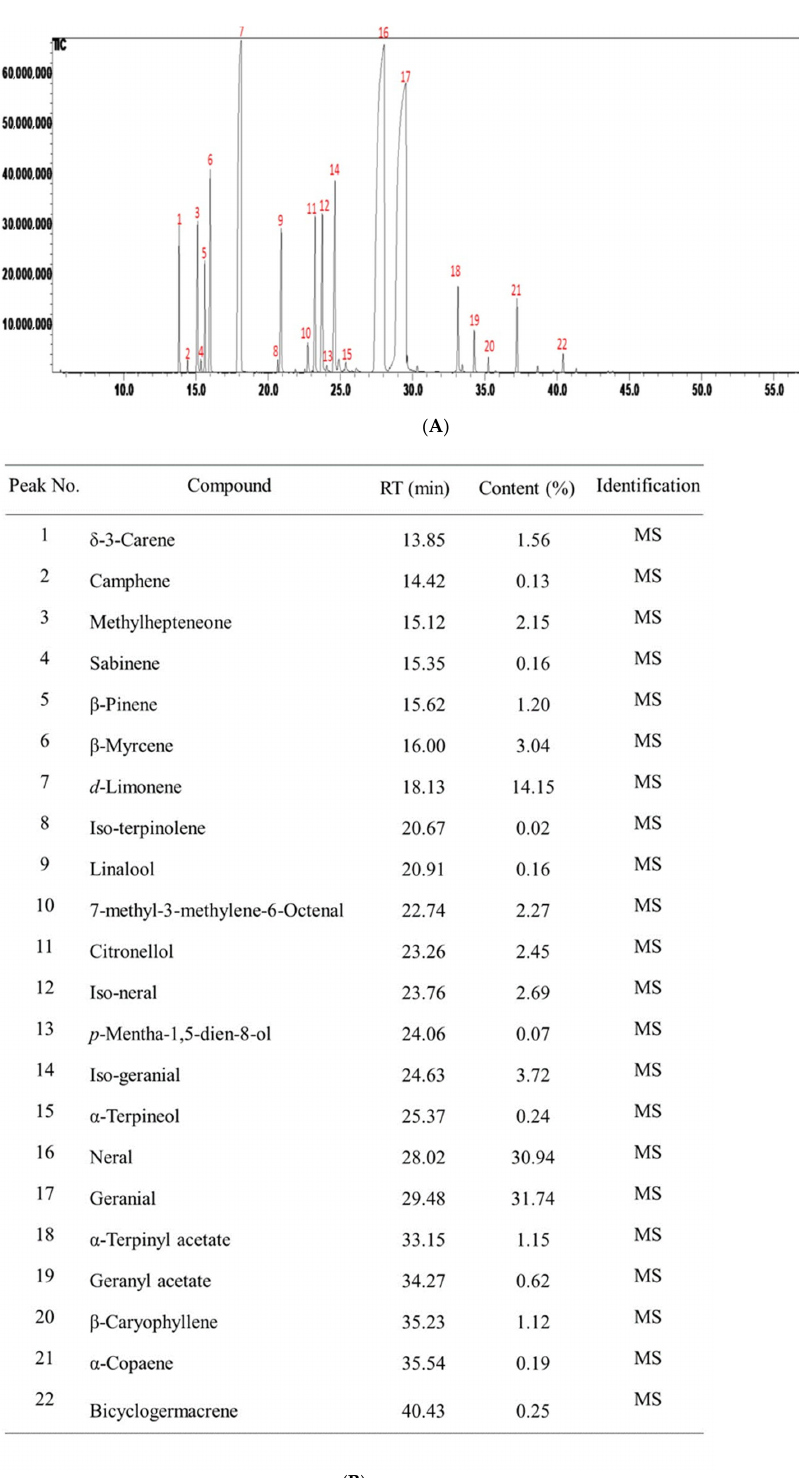
Figure 2. ( A ) GC chromatograms and ( B ) GC/MS analysis of volatile compounds of Litsea cubeba Persoon fruit essential oil from Alang Gluban tribe of Nantou County in Taiwan. Mass spectra compared with those of the NIST14 Mass Spectral database. The Likens ‐ Nickerson apparatus was used to extract essential oils from the LCP fruit. The GC/MS analysis determined the main volatile compounds of LCP fruit essential oil to be d ‐ limonene (14.15%) and citral (geranial + neral) (62.68%); see many previous reports